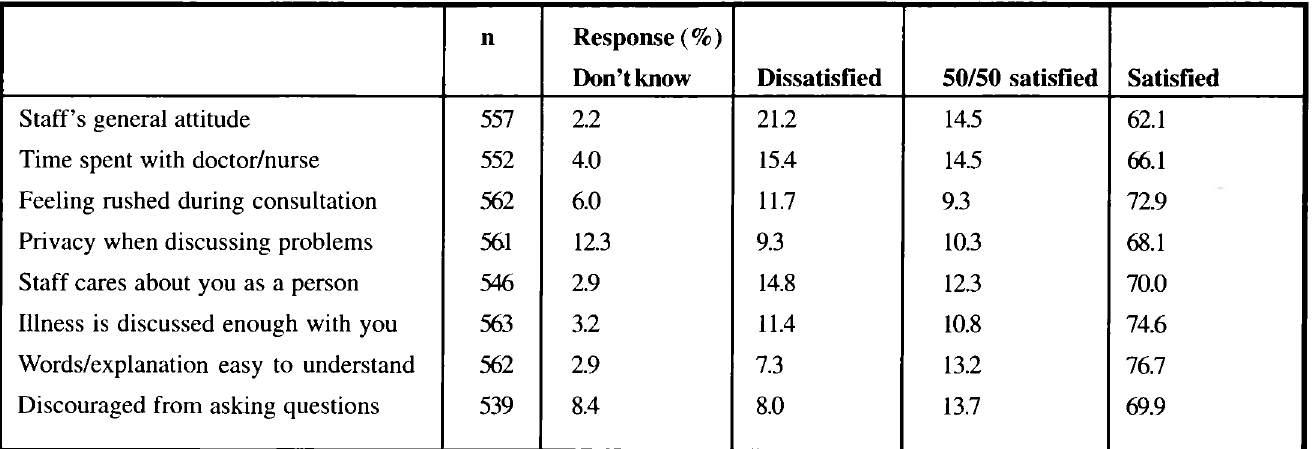
Table 3: Health care worker / patient relationship and health promotion I education n Response